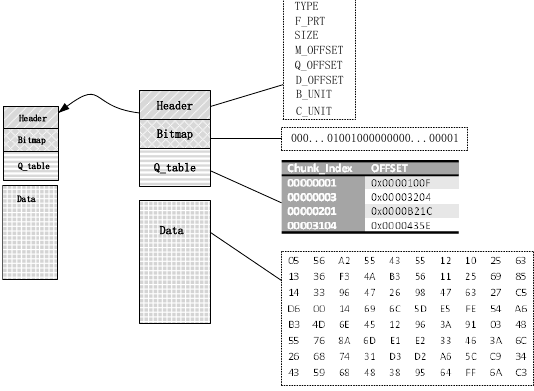
Figure 7. The Vdisk storage